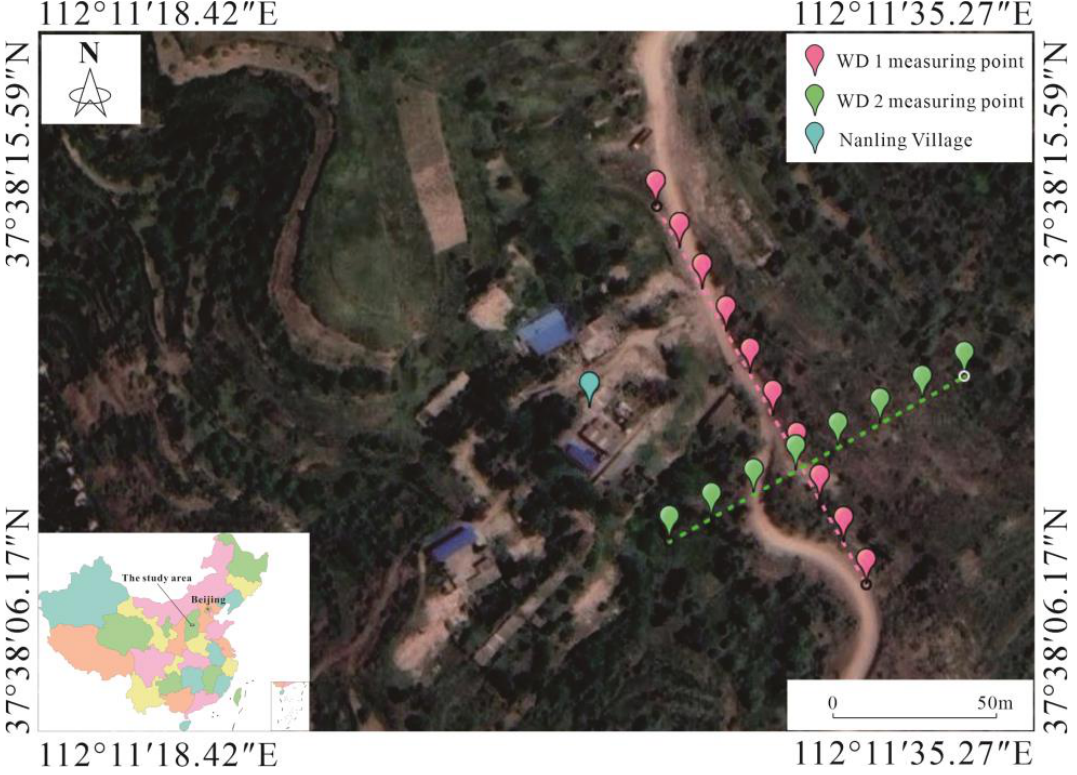
Figure 3. The location of the survey area and the arrangement of the array.